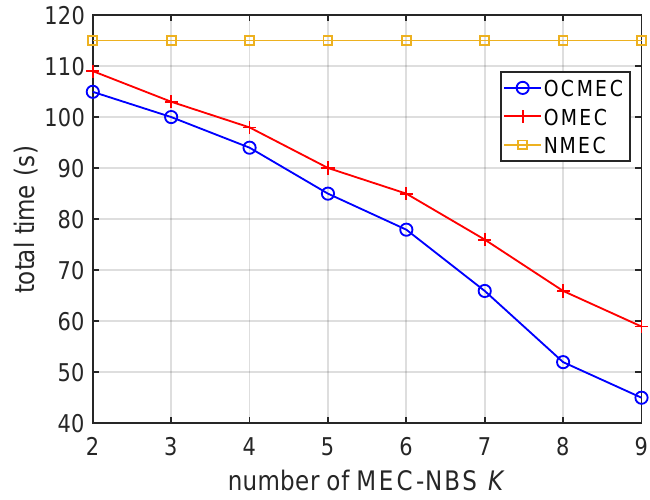
Figure 6. f gained by the 3 schemes with the increase of K .